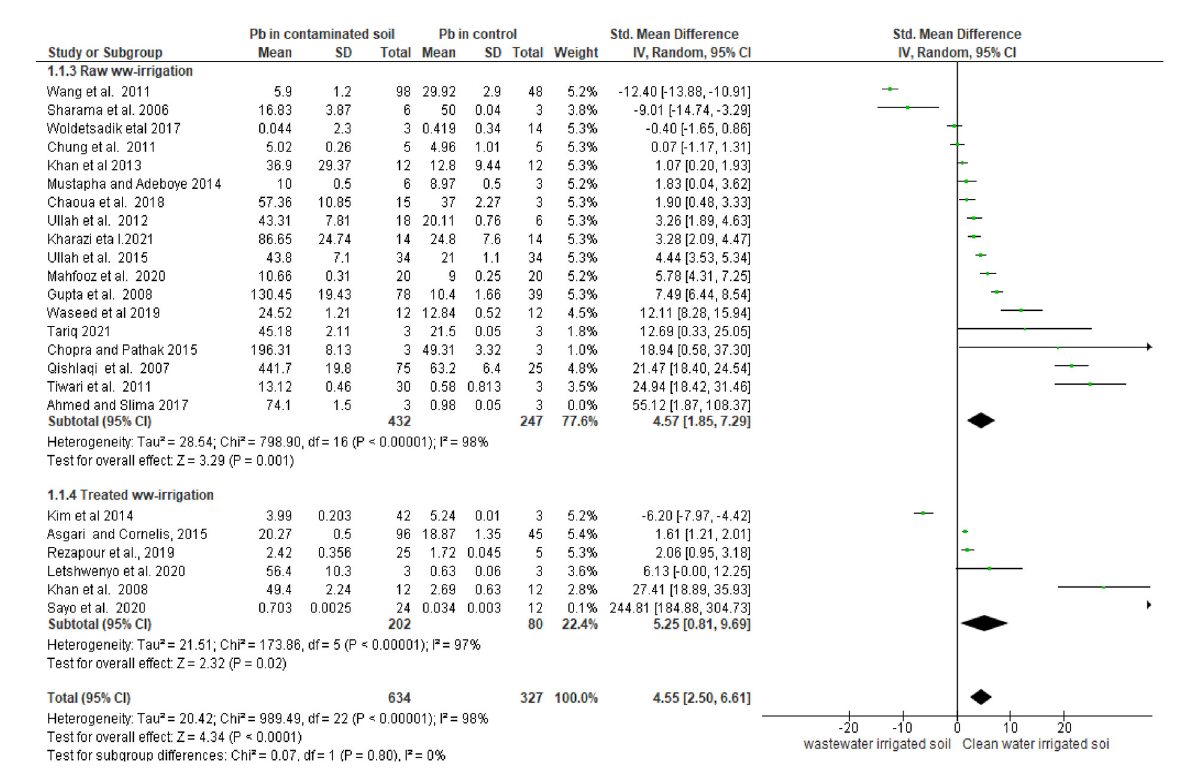
FIGURE5 Mean effect sizes of random-effect models (mean Hedges’ g ± 95% confidence interval) for Pb accumulation in wastewater irrigated soil vs uncontaminated soil. Values in brackets refer to the number of comparisons from which the mean effect size was calculated. A negative g value means higher Pb concentration in wastewater irrigated soil than uncontaminated sites. The mean effect size was considered statistically significant if the 95% bootstrap confidence interval (CI) did not include zero. CIs of continuous measures that include 0 represent no significant results.